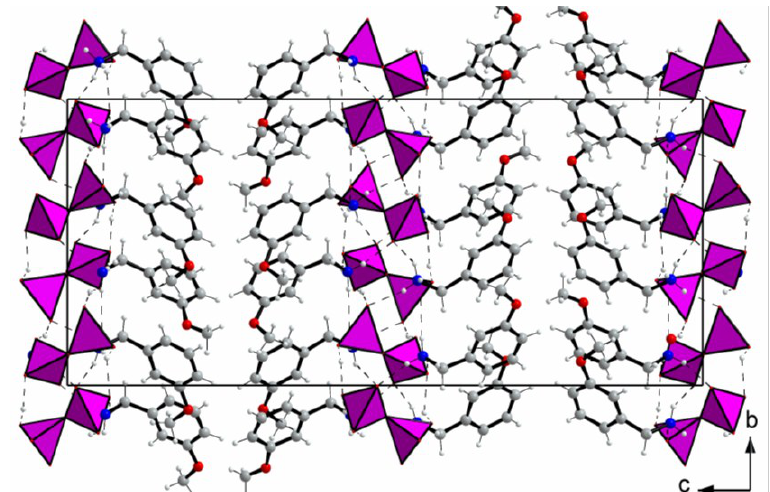
Figure 2. Projection along the a direction of the atomic arrangement in